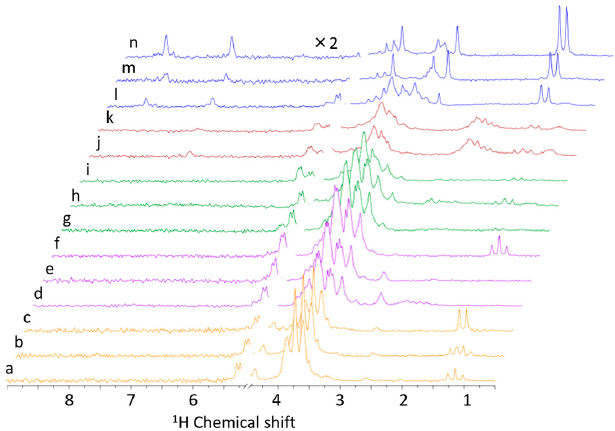
Figure 2. Typical experimental bench-top 60-MHz NMR spectra for processed foods deposited in FoodPro. ( a ) Milk with freshly added yogurt; ( b ) 6-h fermented milk with yogurt; ( c ) 20-h fermented milk with yogurt; ( d ) tomato fruit extract; ( e ) blueberry extract without fermentation; ( f ) 10-day fermented blueberry extract; ( g ) radish pickled in fermented rice bran; ( h ) cucumber pickled in fermented rice bran; ( i ) carrot pickled in fermented rice bran; ( j ) ramen soup with dried small sardines;, ( k ) ramen soup with pork bone and soy broth; ( l ) pickled bluefin tuna fermented in soy sauce; ( m ) raw sardine muscle extract; and ( n ) raw bluefin tuna extract.